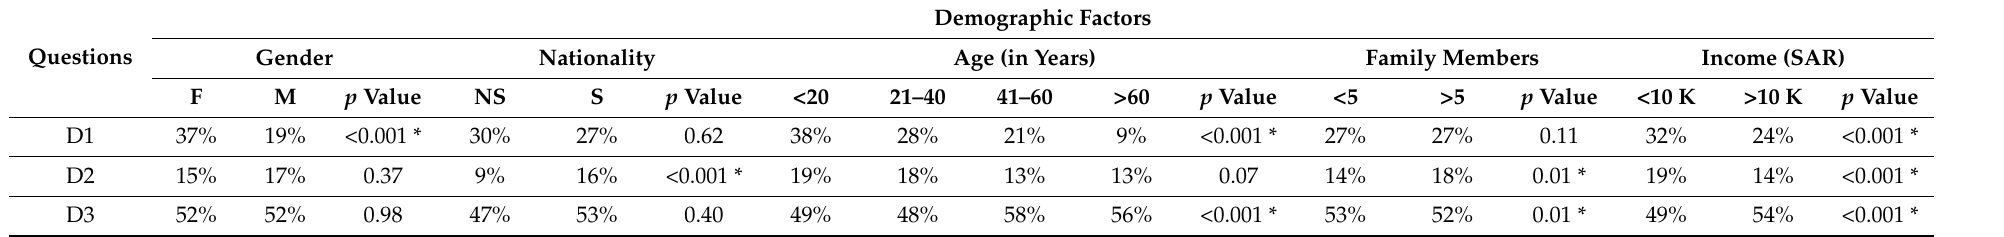
Table 5. Comparison of the effect of demographic factors on oral health care perception